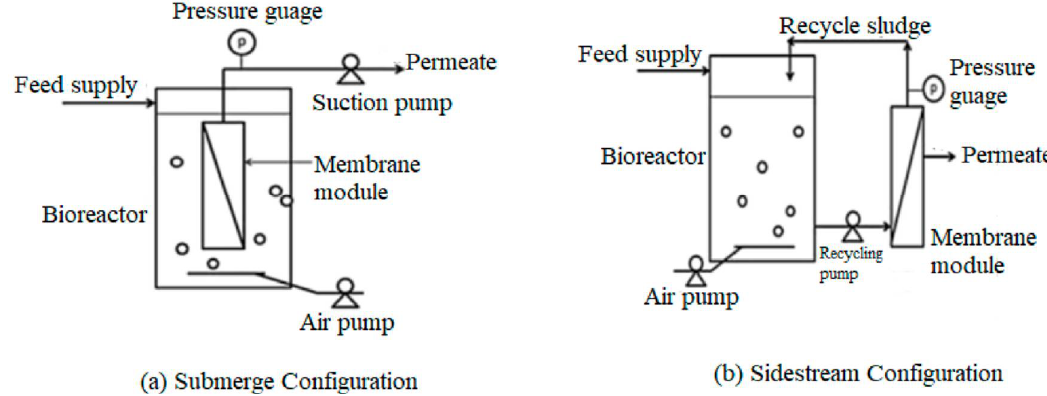
Figure 3. Schematic of Membrane Bioreactor (MBR) configurations ( a ) submerged, ( b ) side-stream